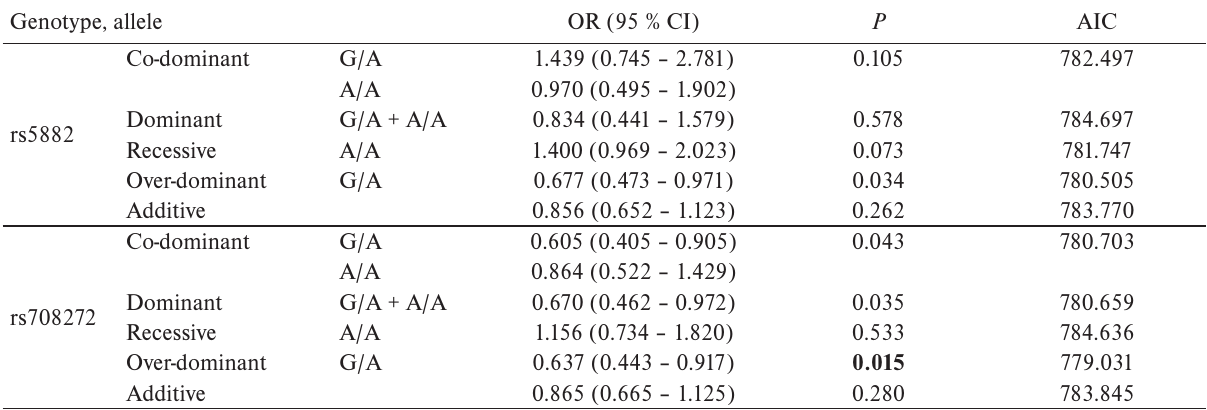
Table 2. Binomial logistic regression analysis of patients with PA and control group